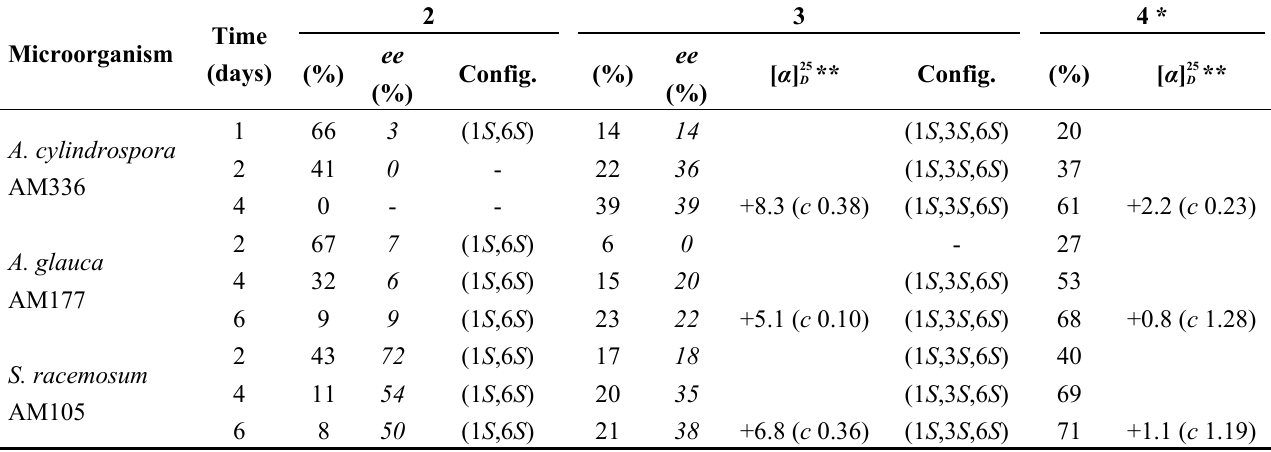
Table 2. The composition (according to chiral GC) of the products mixture in the course of preparative microbial transformation of lactone (±)- 2 .